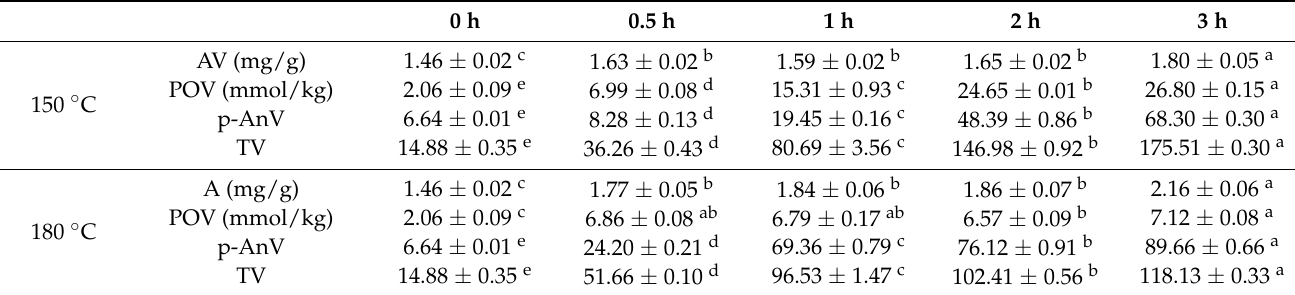
Table 5. Changes in AV, POV, p-AnV and TV of HOPNO&SSO oil blend during